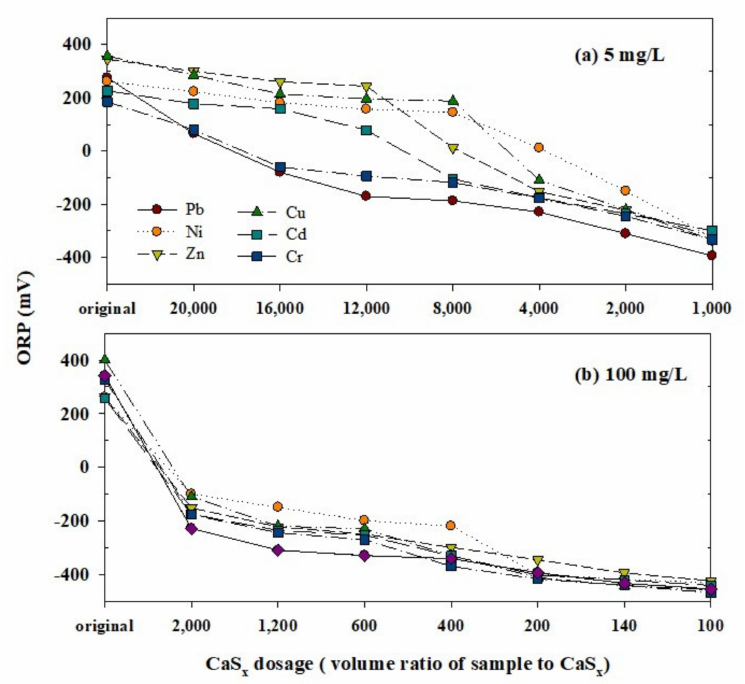
Figure 2. The changes in the ORP of various metal aqueous solutions when different dosages of calcium polysulfide were added, ( a ) for concentration of 5 mg/L, ( b ) for concentration of 100 mg/L.